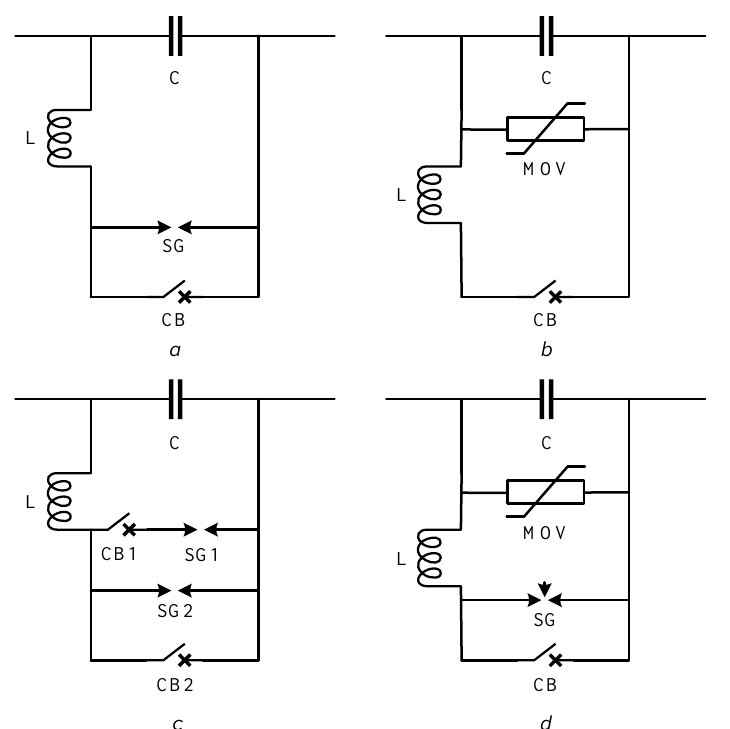
Figure 6. Common capacitor bank protection configurations ( a ) SG and CB in parallel with series inductor, ( b ) CB and inductor in series with parallel MOV, ( c ) multiple CB and SG and ( d ) MOV, SG and CB in parallel with series